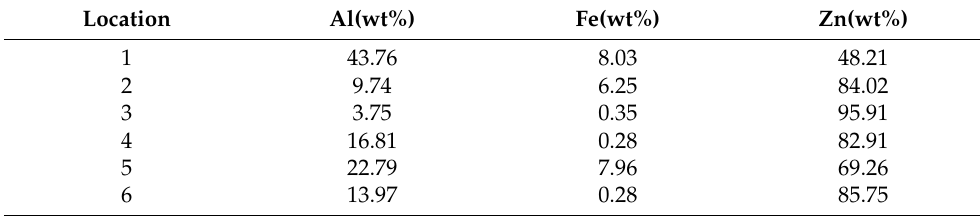
Figure 6. Morphology and energy spectrum analysis of 450-30-A hot dip plating layer under SEM, ( a ) cross-sectional morphology of hot dip plating layer; ( b ) morphology of hot dip plating layer and corresponding micro-area energy spectrum analysis. Table 9. Point scan and surface scan results of 450-30-A hot dip plating.